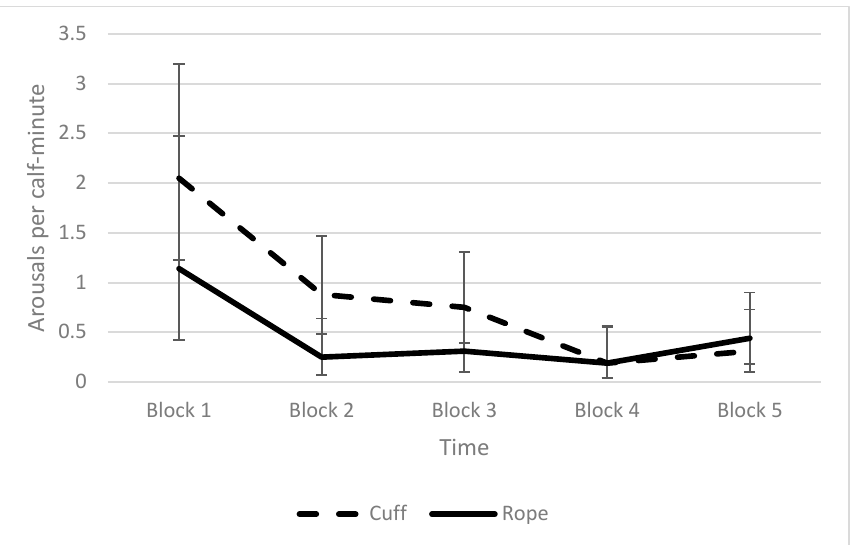
Figure 7. Average (+SD) rate of low-intensity arousals per 2 min with 95% confidence intervals for the calves squeezed with the cuff or rope, calculated for five time blocks over the 10-min observation period. The duration of block 1 varied among the individual calves depending on induction time, while all of the other blocks were two minutes long. The number of calves in each time block dropped from 13 calves in block 1 to 8 calves in block 5 ( n = 5 rope, n = 3 cuff) because the squeeze was discontinued for some of the calves.